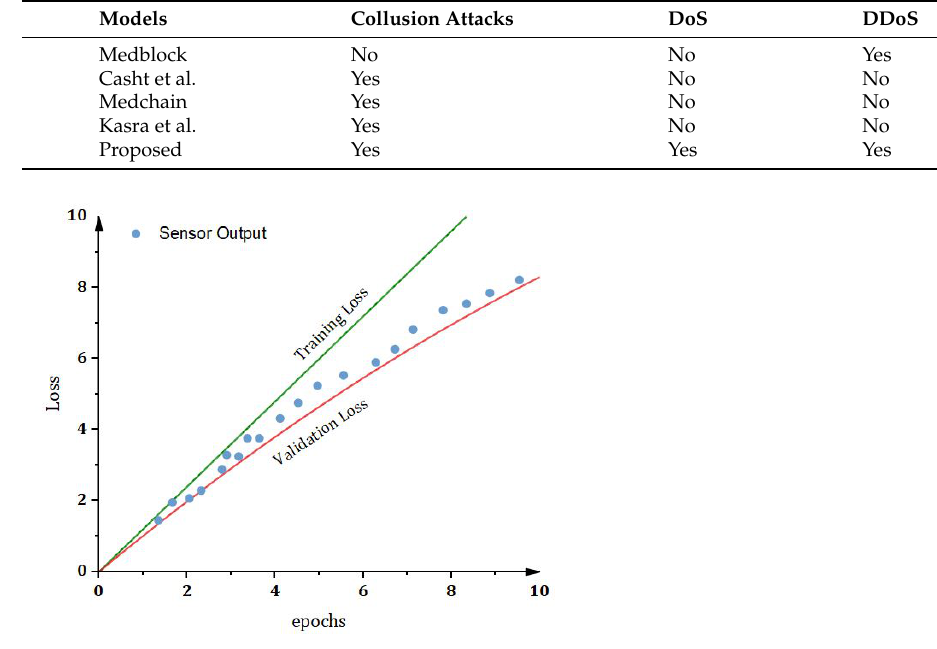
Figure 22. The Accuracy vs. loss for validating the proposed method using IoT dataset.